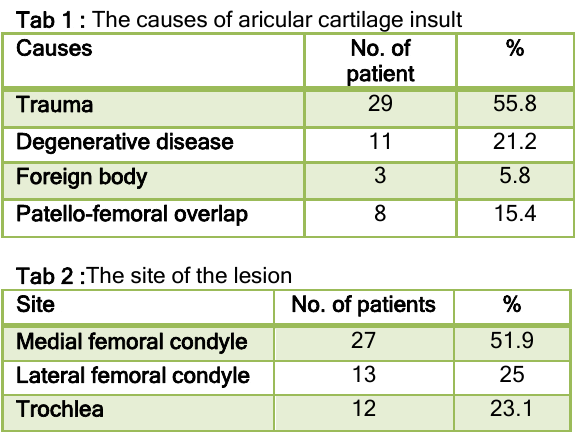
Tab 3 : Clinical outcome according to Lyshlom score